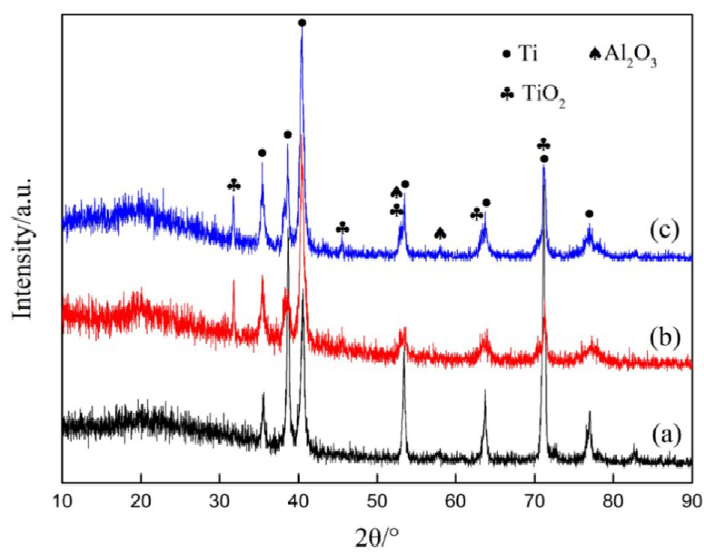
Figure 3. XRD patterns of ( a ) the polished TC4 alloy substrate, ( b ) the sample after laser marking, and ( c ) the sample after laser marking and anodizing (Al 2 O 3 and TiO 2 peaks are overlapped in several intense